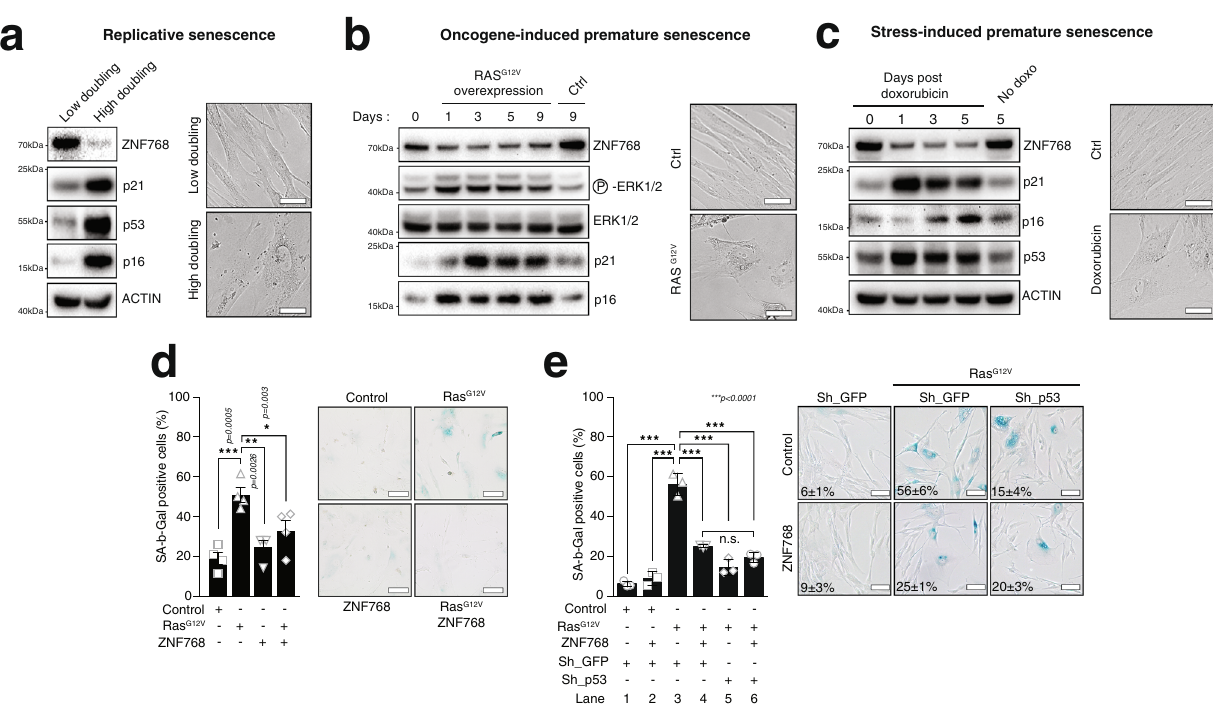
Fig. 4 ZNF768 is depleted upon senescence entry and its overexpression contributes to bypass this process. A Protein lysates were prepared from IMR90 cells at Low or High population doublings. Western blot analyses were performed for the indicated proteins. Representative pictures of the cells are shown on the right part of the panel (Scale: 50 µ m). B IMR90 cells were transduced with lentiviruses to overexpress a constitutively active form of RAS G12V . Protein lysates were prepared at the indicated time following the overexpression and western blot analyses performed for the indicated proteins. Representative pictures of the cells are shown on the right part of the panel (Scale: 50 µ m). C IMR90 cells were treated overnight with doxorubicin (0.1 µ M). The cells were next washed and followed for the indicated times. Western blot analyses were performed for the indicated proteins. Representative pictures of the cells are shown on the right part of the panel (Scale: 50 µ m). D Primary MEFs were transduced with retroviruses expressing different combinations of FLAG-ZNF768, RAS G12V , or empty vector. After antibiotic selection, cells were maintained in culture until the fi rst signs of senescence bypass were visible. Cells were then fi xed and SA- β -gal assays were performed. The percentage of SA- β -gal positive cells is shown. The result presented is the average of four independent experiments ( n = 4). Representative images are shown (Scale: 100 µ m). E IMR90 cells were transduced with retroviruses expressing different combinations of FLAG-ZNF768, shGFP, shp53, RAS G12V , or empty vector. After antibiotic selection, cells were maintained in culture for 8 days. Cells were then fi xed and SA- β -gal assays were performed. The percentage of SA- β -gal positive cells from three independent counts are indicated and representative images are shown for each condition (Scale: 100 µ m). In panels D and E , mean values were compared through a one-way ANOVA with Tukey ’ s multiple-comparisons test. Details about reproducibility are provided in the Statistics and reproducibility included in the Methods section. Source data are provided as a Source data fi